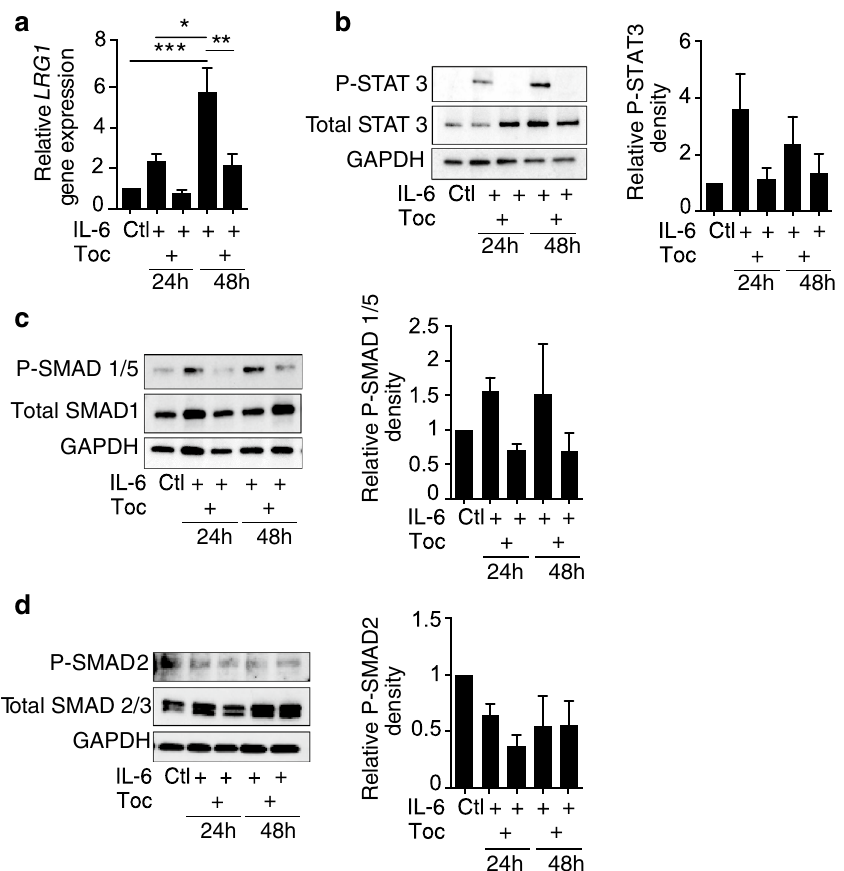
Figure 5. Tocilizumab antibody blocks LRG1 gene expression. HPMEC cells treated with PBS as control (Ctl), 50 ng/ml IL-6, and 20 μg/ml Tocilizumab (Toc) antibody in combination with IL-6 as indicated. RNA and protein were extracted and subjected to RT-qPCR and western blotting. ( a ) Human LRG1 gene expression normalised to HPRT housekeeping genes. Protein expression of phosphorylated and total STAT3 ( b ), SMAD1/5 ( c ) and SMAD2 ( d) . Quantification was performed by densitometric analysis of normalised phosphorylated to normalised total protein using ImageJ. Representative images of cropped blots (original blots are provided in the supplementary information). N ≥ 3 independent experiments. ANOVA with multiple comparisons test (Tukey’s), Mean ± SEM, * ≤ 0.05, ** ≤ 0.01, *** ≤